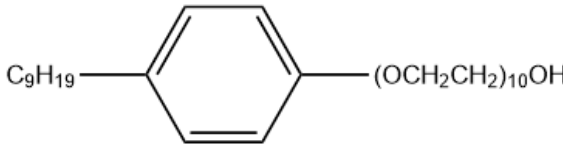
Figure 7. Structure of NPEO 10 .